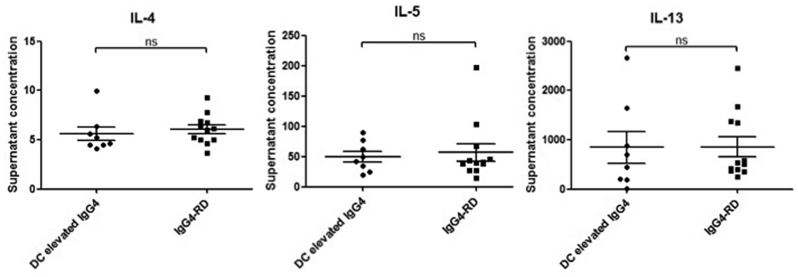
Th2 cytokine response in IgG4-RD patients, disease controls and healthy controls. Dot plots of the concentrations of the Th2 cytokines IL4, IL5 and IL13 in supernatants derived from cultured B cell ELISpots. In this assay PBMCs were stimulated non-specifically for 6 days, which elicits lymphocyte expansion and cytokine production. Kruskal-Wallis test with multiple comparisons p values; ns p ≥ 0.05.